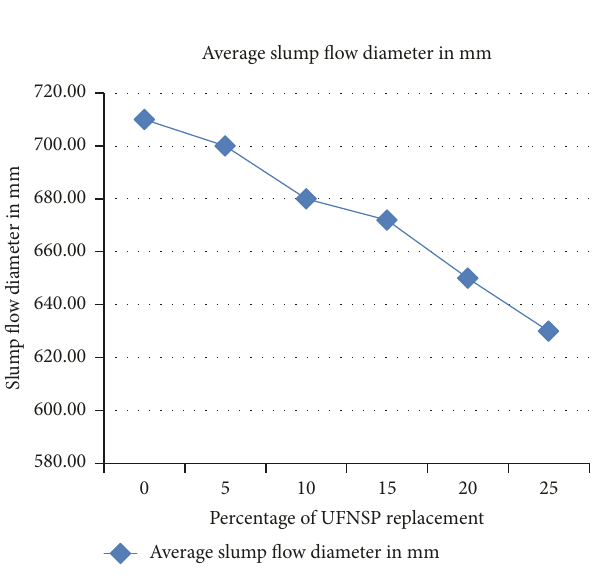
Figure 4: Results on slump flow test.